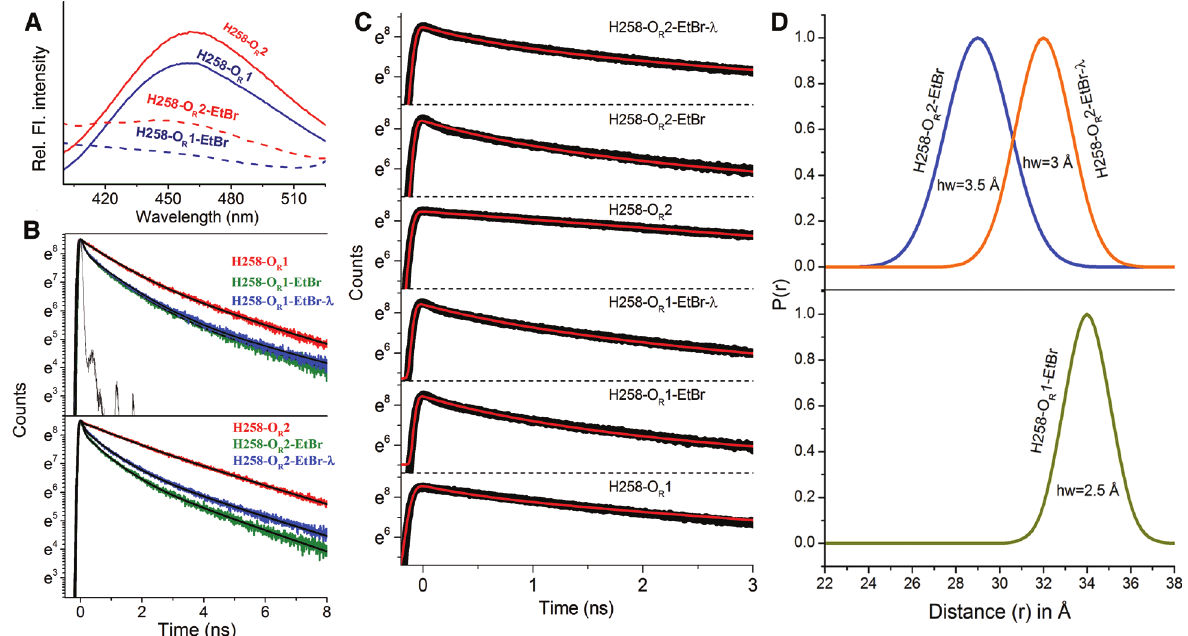
Figure 15 Steady-state and time-resolved FRET quenching and Tachyia kinetic model analysis. (A) Steady-state emission spectra of H258 in operator DNA in presence and in absence of EtBr. (B) The fluorescence lifetime quenching of H258. Upper panel shows the effect of EtBr in O 1 system and the lower panel depicts the energy transfer for O R resolved lifetime data of H258 under various conditions by Tachiya kinetic model. (D) Probability of distance distribution (P(r)) with respect to mean donor-acceptor distance.